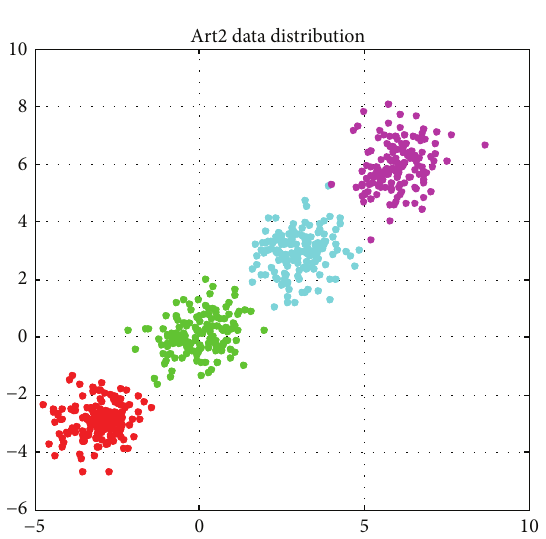
Figure 4: The distribution image of Art2.